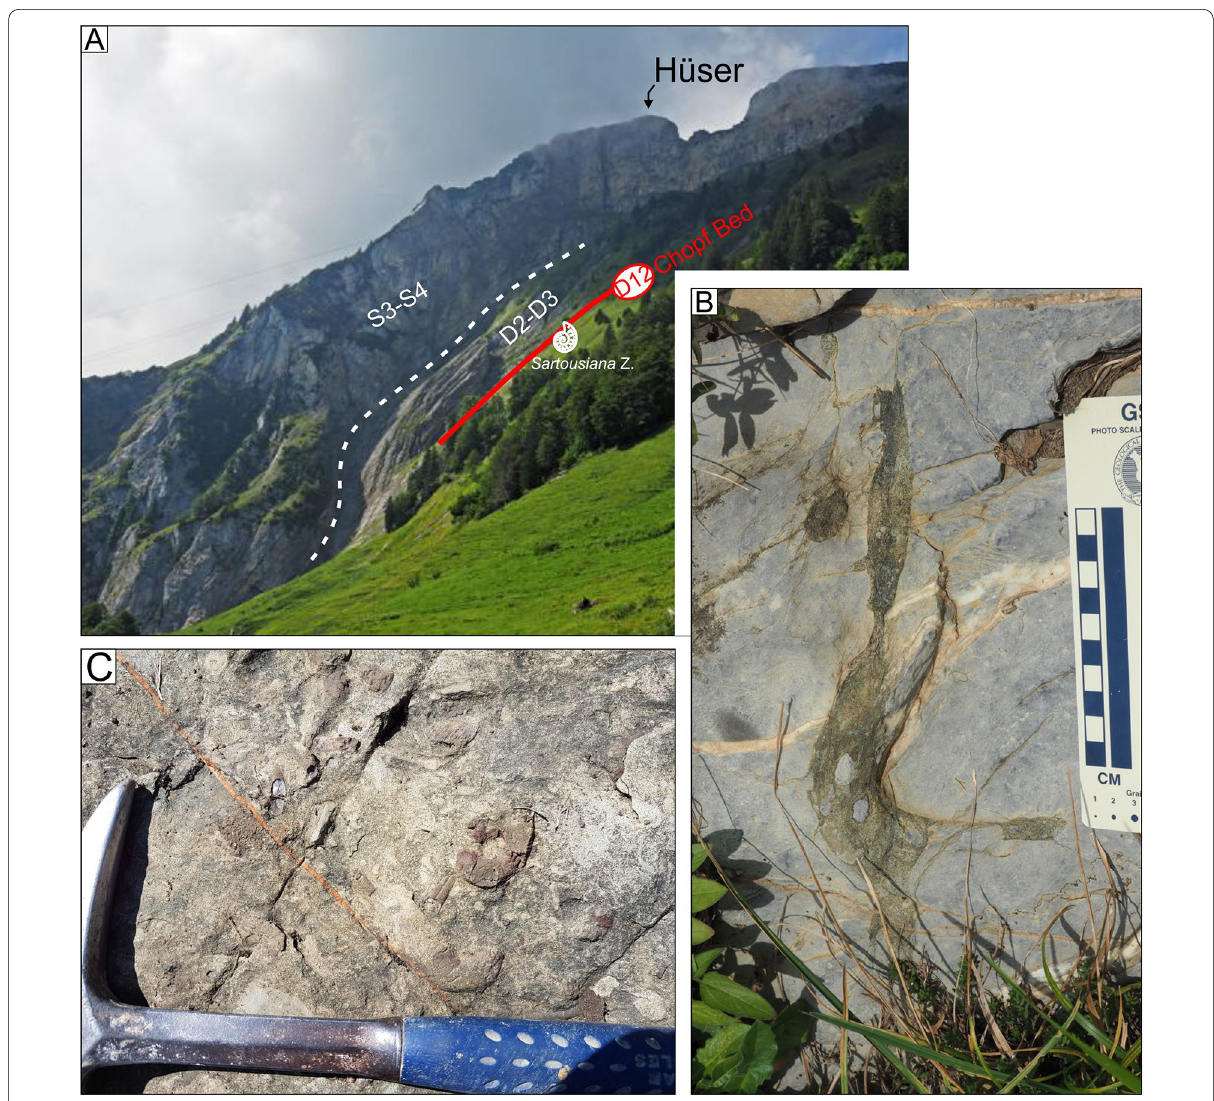
Fig. 15 Photographs of the south-eastern mountain range. A View on the Hüser cliff from Frümsner Alp with the stratigraphical position of the Chopf Bed, the Drusberg Member and the Schrattenkalk Formation. B Focus on the bioturbated firmground (D12) at the base of the Chopf Bed with its glauconitic infill, Frümsner Alp. C Focus on the overlaying Chopf Bed at Alp